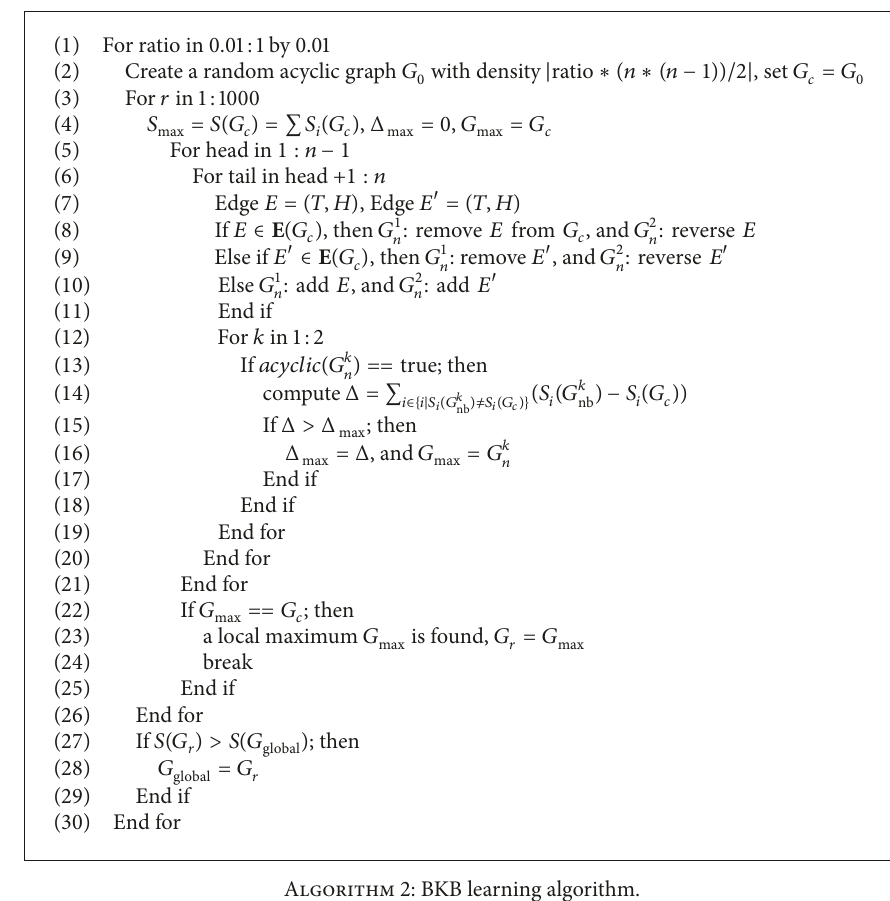
Algorithm 2: BKB learning